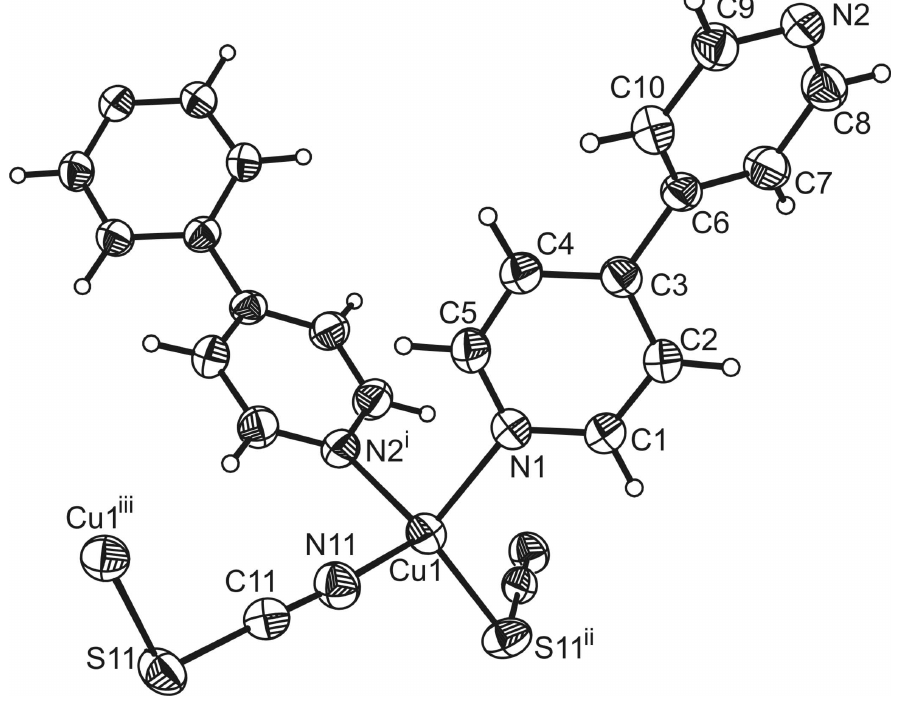
Crystal structure of the title compund with labelling and displacement ellipsoids drawn at the 50% probability level. [Symmetry codes: i = x , - y + 1/2, z - 1/2; ii = x - 1/2, y , - z + 1/2; iii = x + 1/2, y , - z +